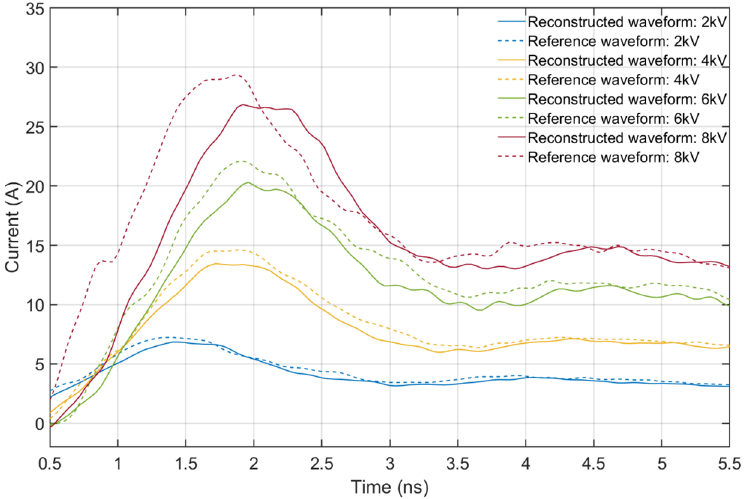
Figure 16. Initial peak comparison of the reconstructed waveform (straight lines) with the Pellegrini target (reference) waveform (dotted lines) for a +2 kV (blue), +4 kV (yellow), +6 kV (green) and +8 kV (red) pulse of the Schaffner NSG 438 generator.